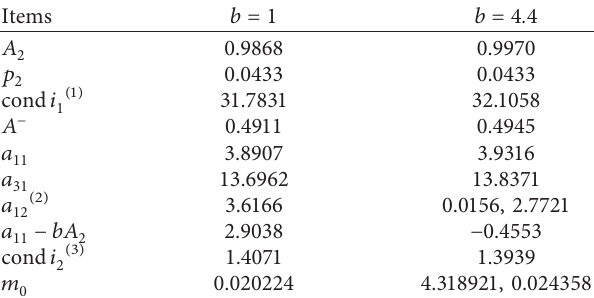
Table 1: The calculation results of the Hopf bifurcation.